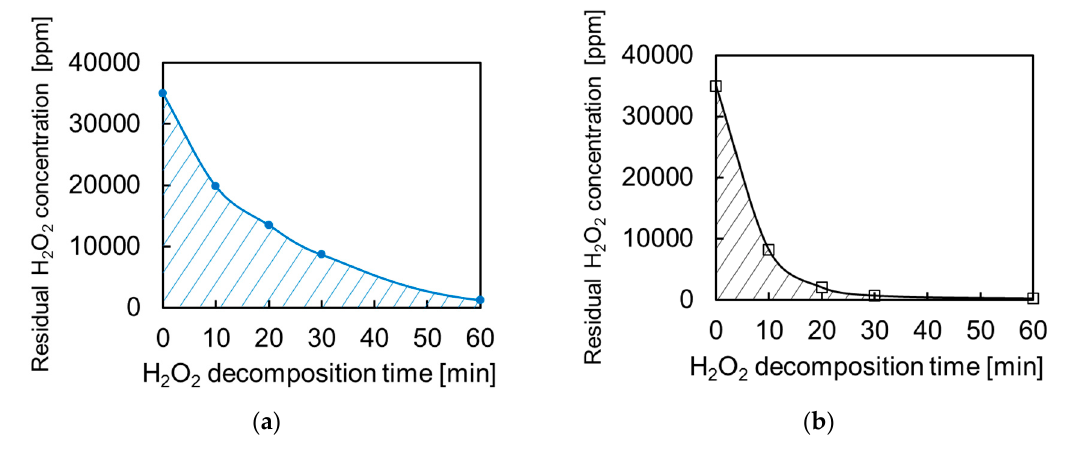
Figure 4. Initial curve of H 2 O 2 decomposition for the ( a ) Pt-particle/ABS and ( b ) Pt-film/ABS samples.